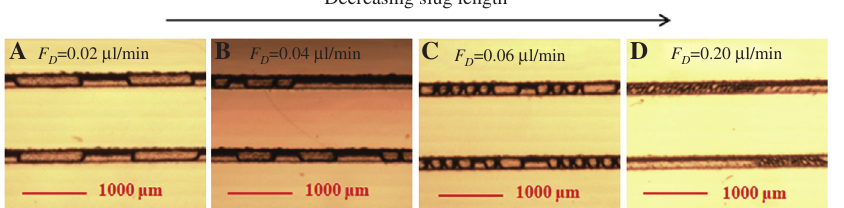
Figure 4 Microscope photographs of the mineral oil-seawater multiphase flow through a microfluidic device for different injection rates of Model Dispersant I: (A) F